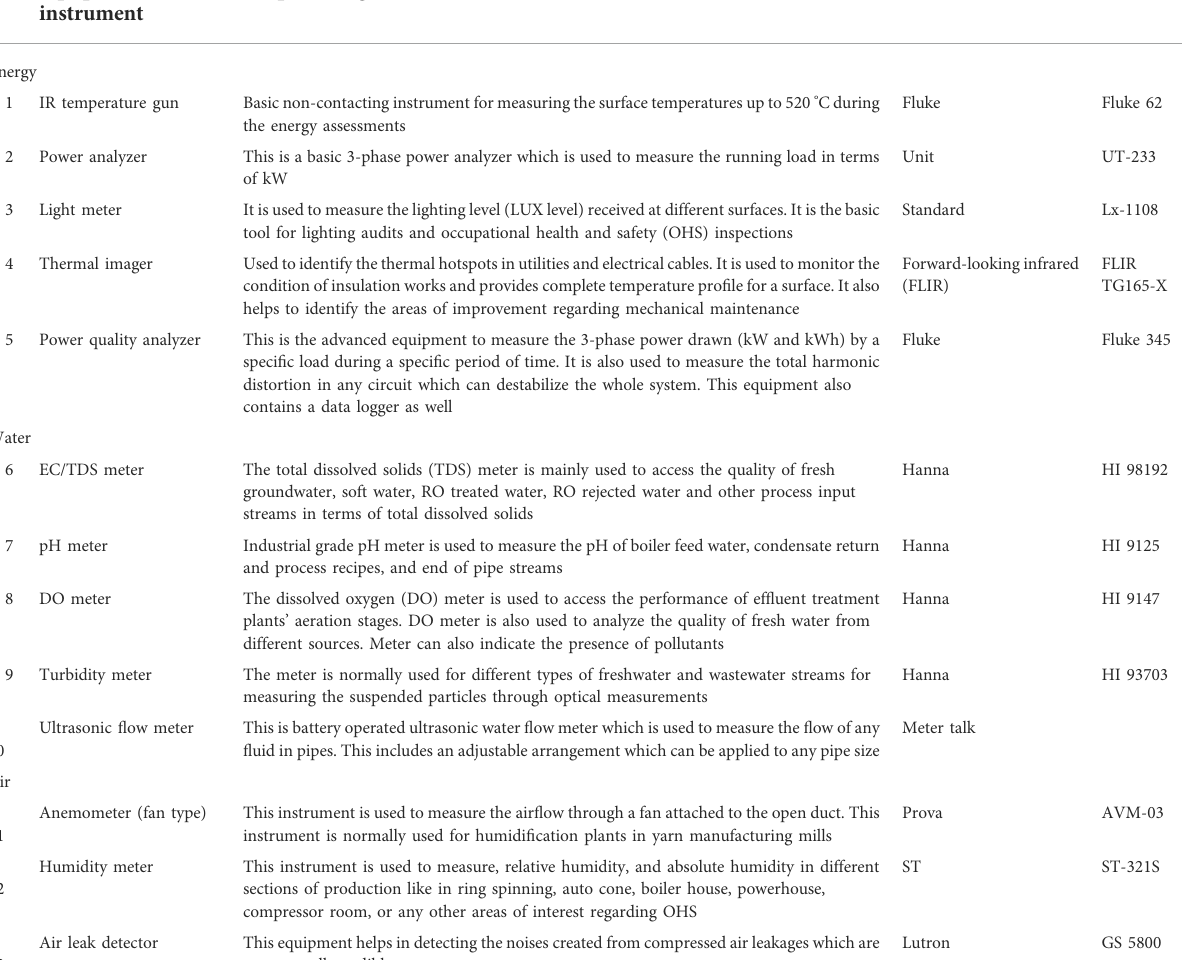
TABLE 2 Equipment used in a detailed analysis of textile